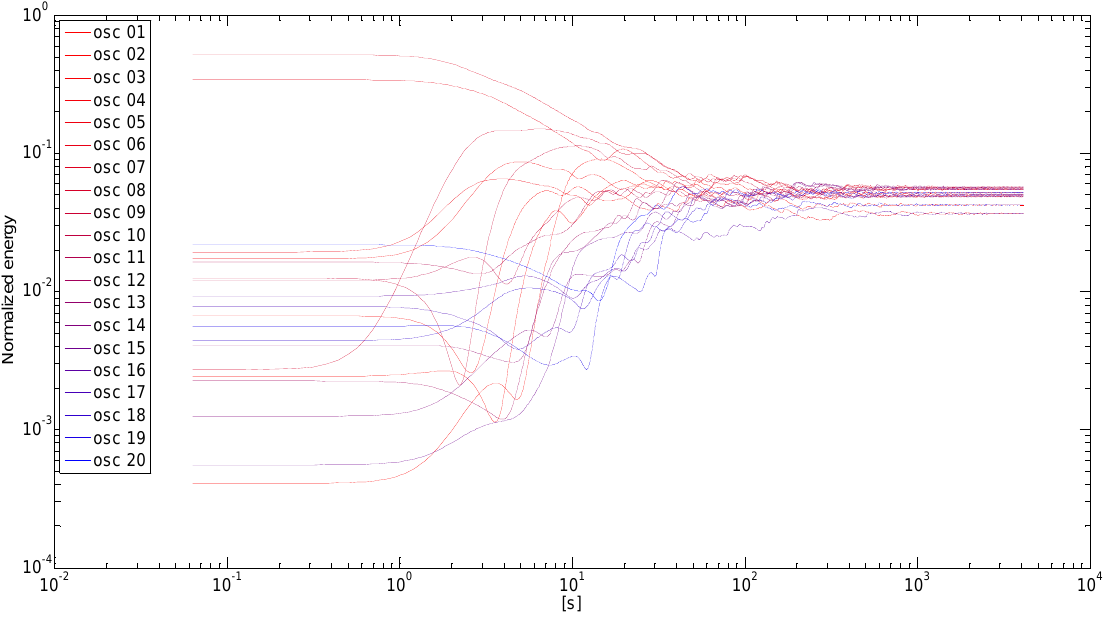
Fig. 5. Uniform chain, time energy averages versus time, x,y axes in log